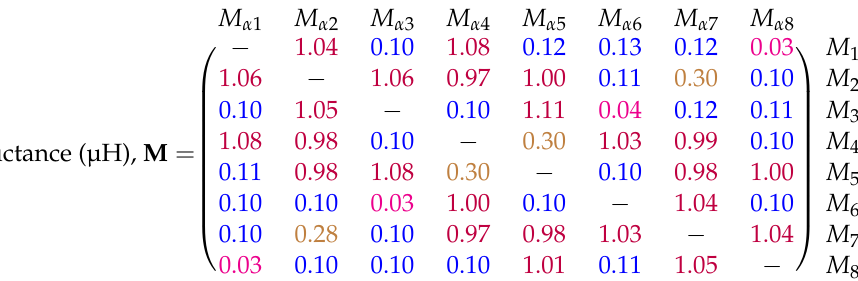
Figure 11. Experimentally calculated mutual inductance matrix for the eight coil magnetic transmitter of the Anser EMT system. The entries have units of microhenries (µH). The diagonal entries are left blank as the system is not built for calculating self-inductances. Results have been truncated and colour-coded for